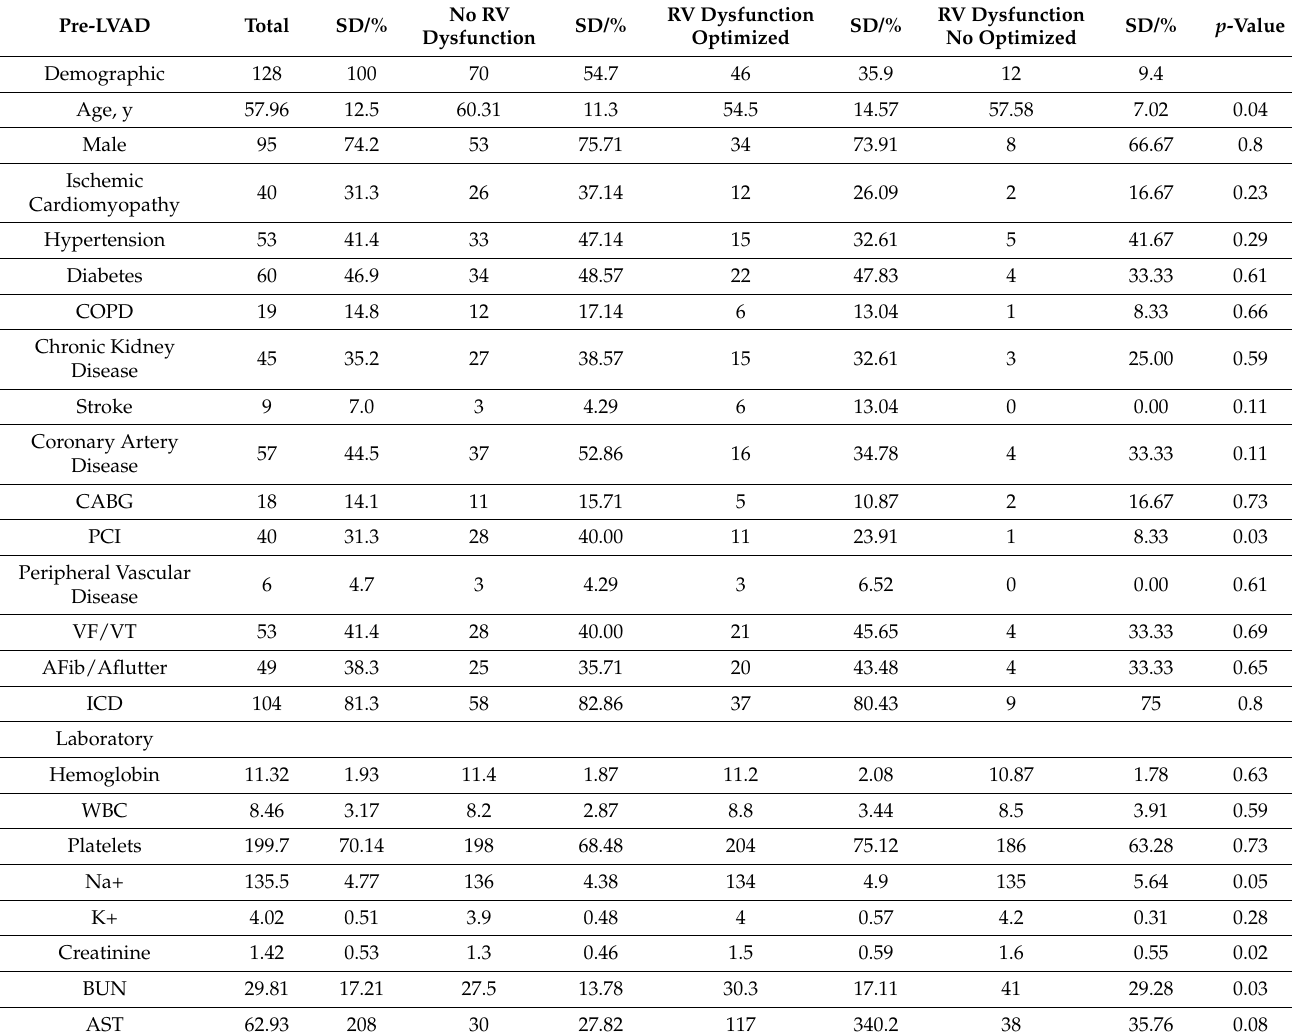
Table 1. Pre-LVAD baseline characteristics among patients with RV dysfunction vs. without RV